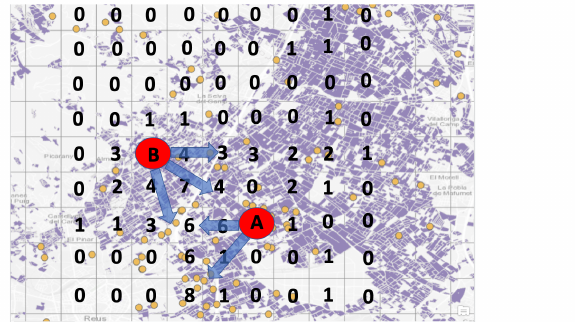
Figure 3. Intuitive behavior of the AIA algorithm.